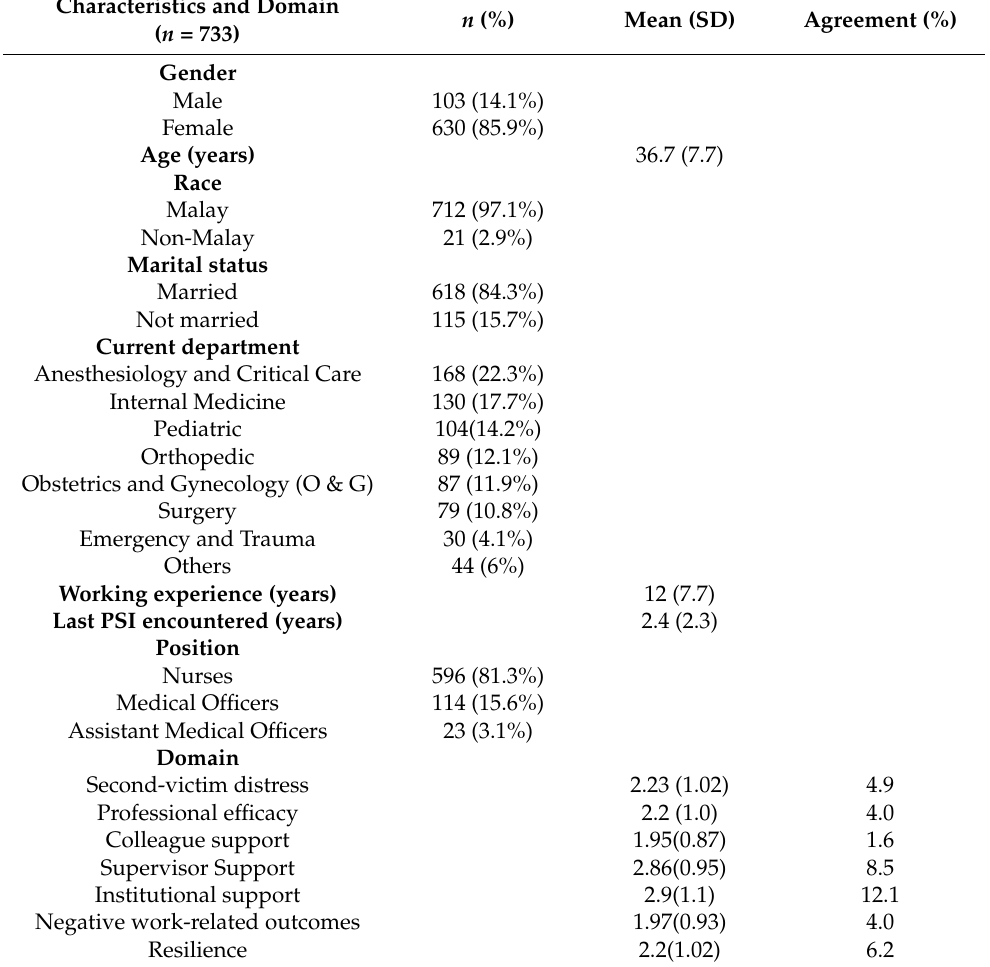
Table 1. Characteristics of respondents and domains ( n =